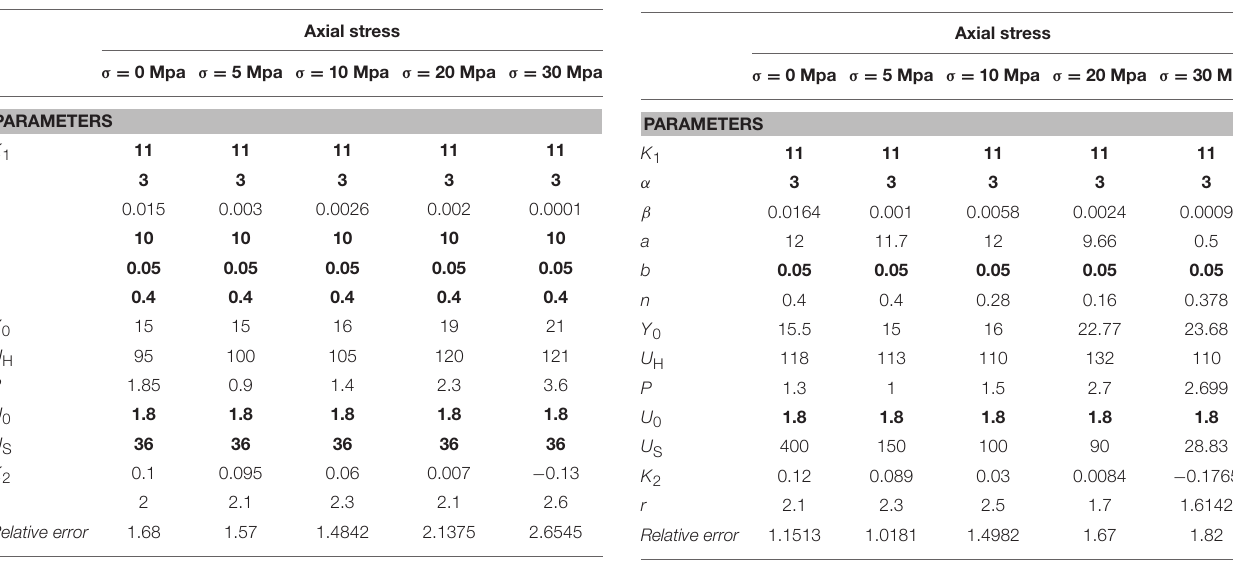
TABLE 4 | Genetic Algorithm method: identified